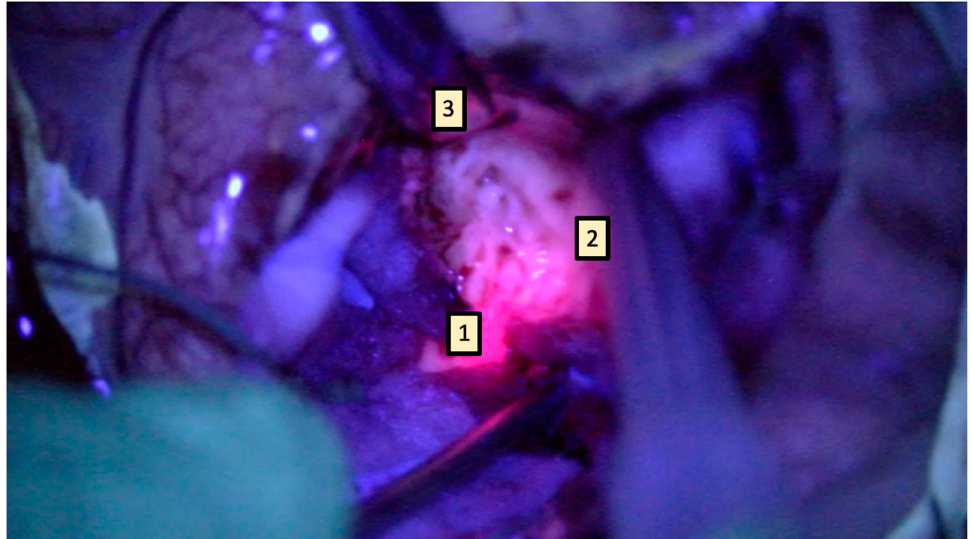
Figure 5. Research suggests that 5-ALA has mainly a refinement role after gross resection. The lava red area represents the tumor core ( 1 ) and the pale area represents the infiltrative margins ( 2 ), surrounded by the negative fluorescent area ( 3 ). Where feasible, it is paramount to extend resection, including the peritumoral “pale” area, without pushing it over neurophysiological boundaries.